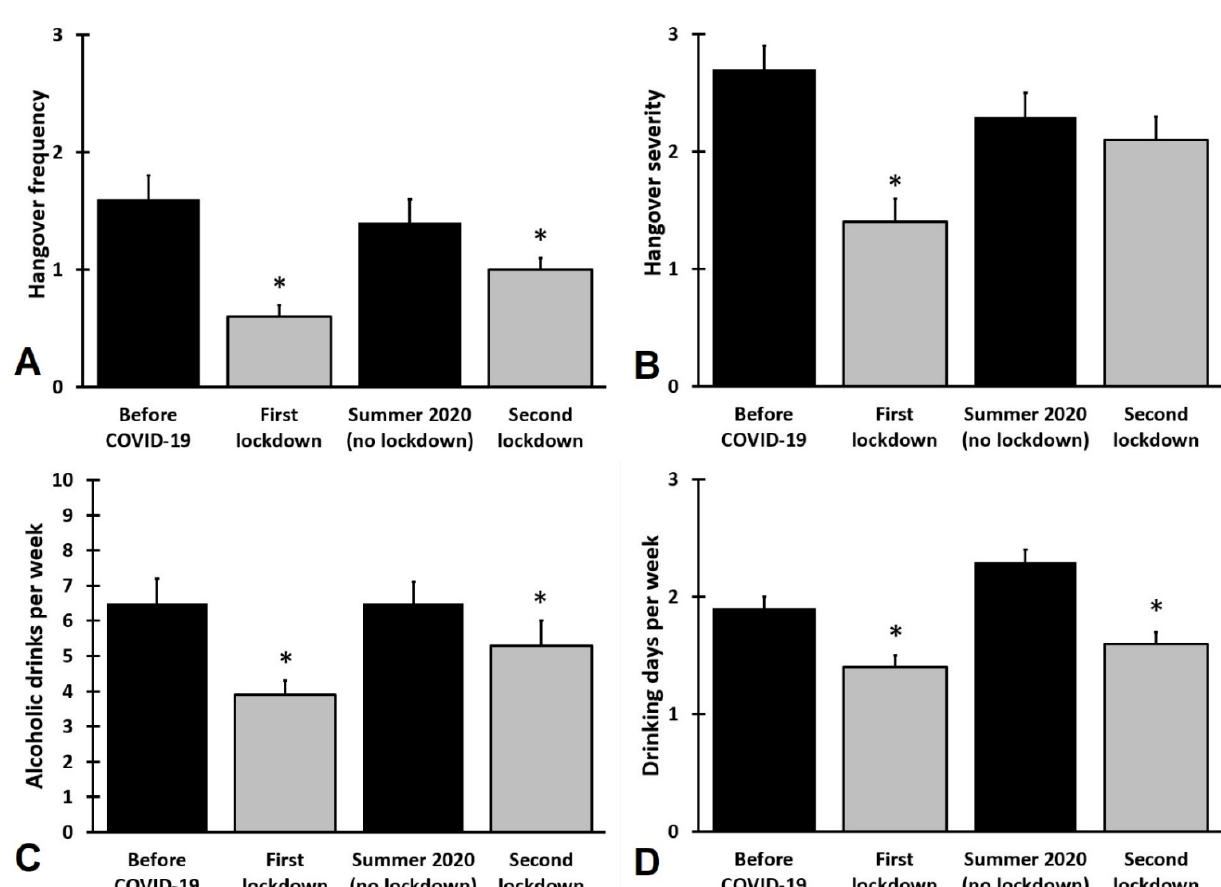
Figure 2. The effect of the COVID-19 pandemic on alcohol consumption and hangovers. Mean and standard errors are shown for hangover frequency ( A ), hangover severity ( B ), alcoholic drinks consumed per week ( C ), and the number of drinking days per week ( D ). Significant differences (adjusted p -values < 0.05, applying a Bonferroni’s correction for multiple comparisons) from ‘before COVID-19) are indicated by *.